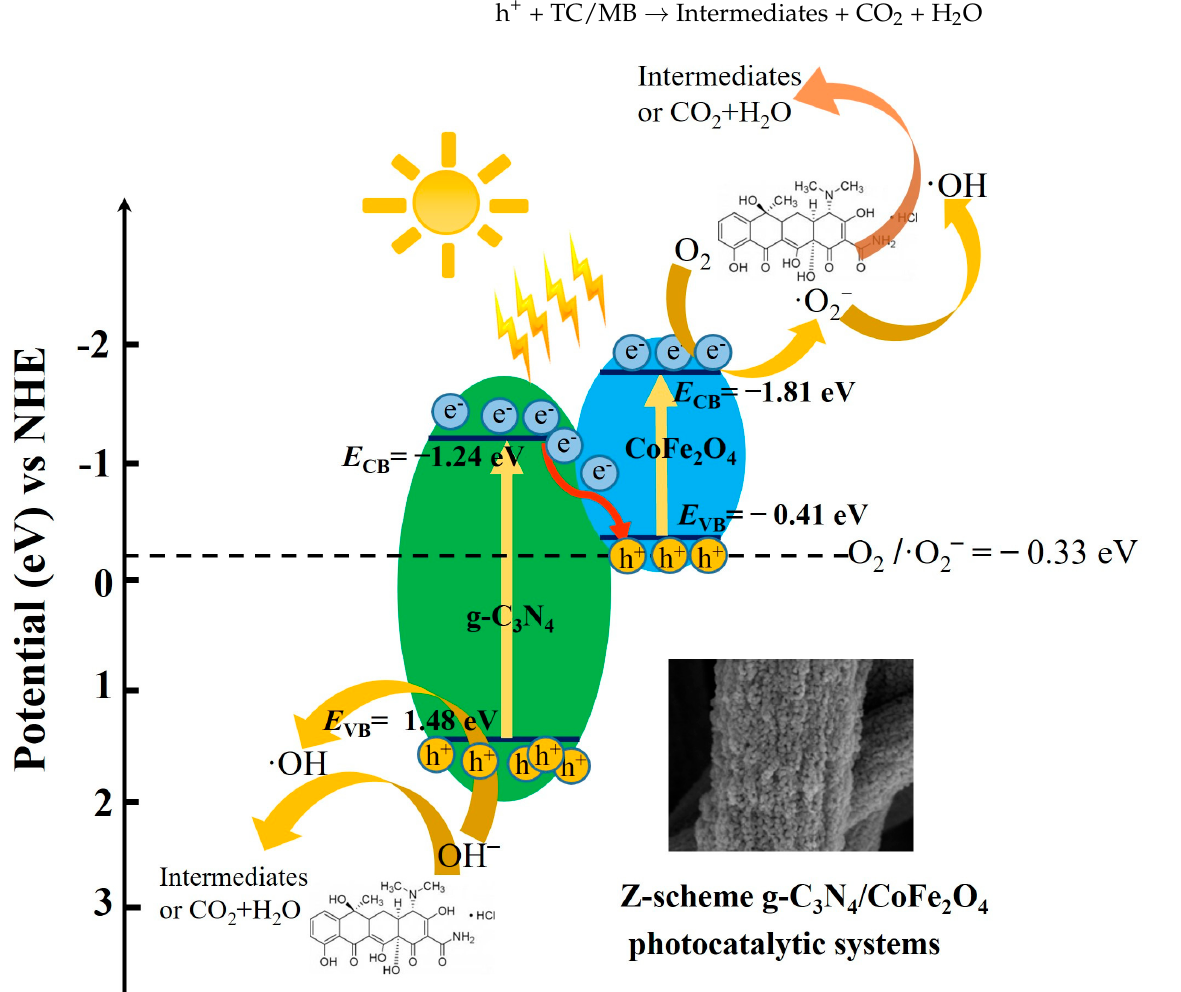
Figure 7. Electron-transfer pathways in the Z-scheme CN/CFO heterojunction composite photocatalysts.